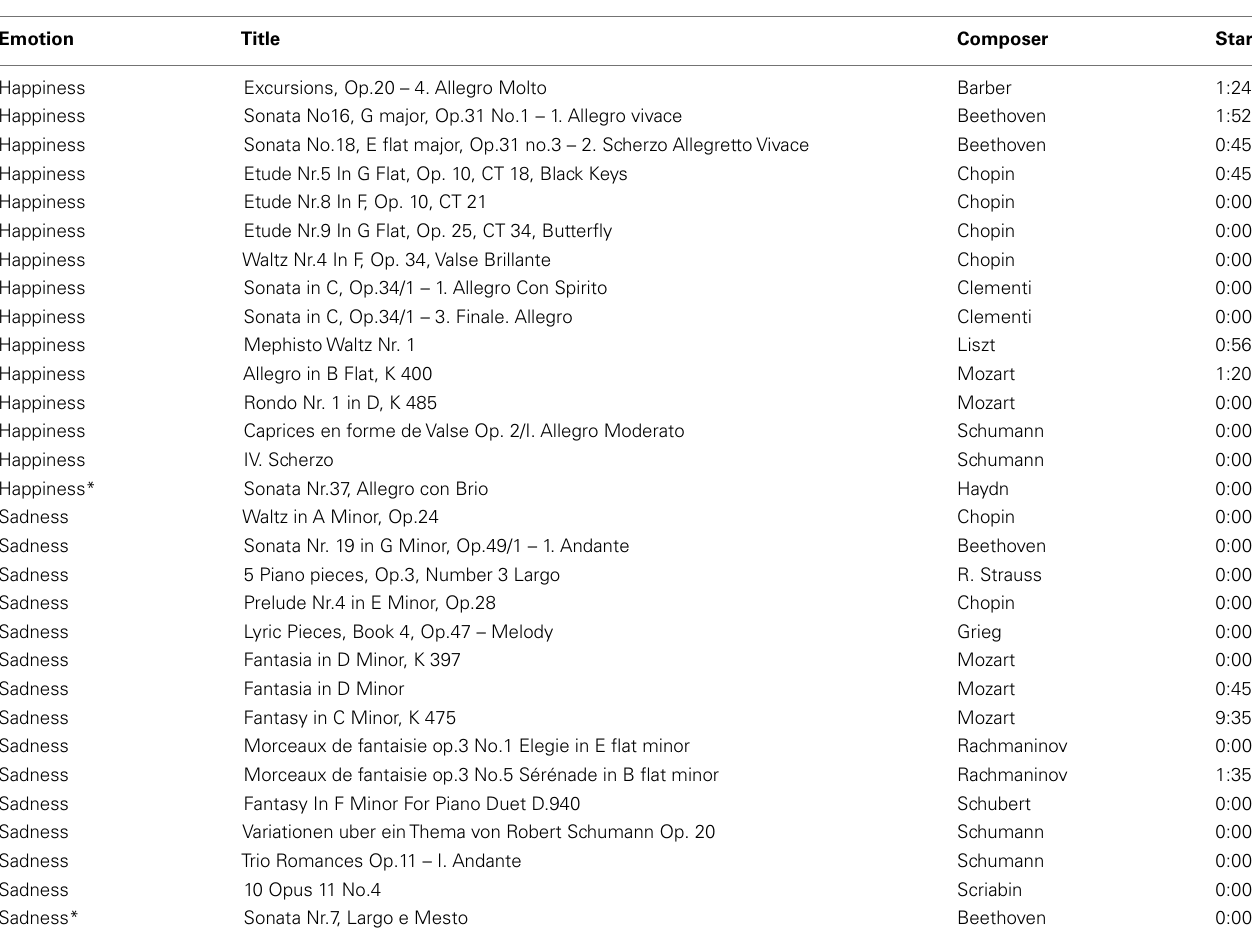
Table 1 | Piano recordings used in Experiments 1 and